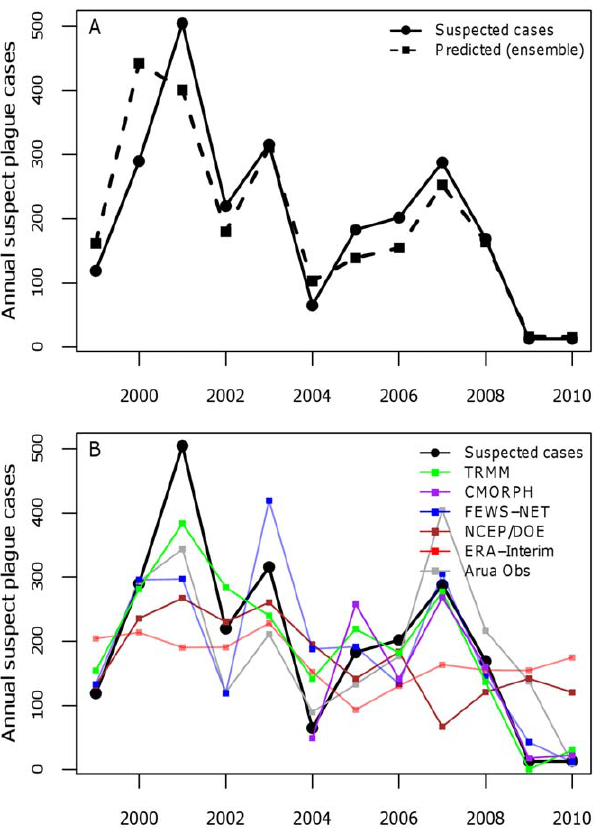
Figure 3. Annual number of observed versus predicted suspect plague cases. (A) Plot of annual number of observed vs. predicted number of suspect human plague cases from the best-fit regression model using the meteorological ensemble dataset that uses a weighted average of all of the rainfall and temperature datasets included in this study (see Table 2 for model details). (B) Predicted number of suspect human plague cases from the best-fit regression model using each of the individual rainfall